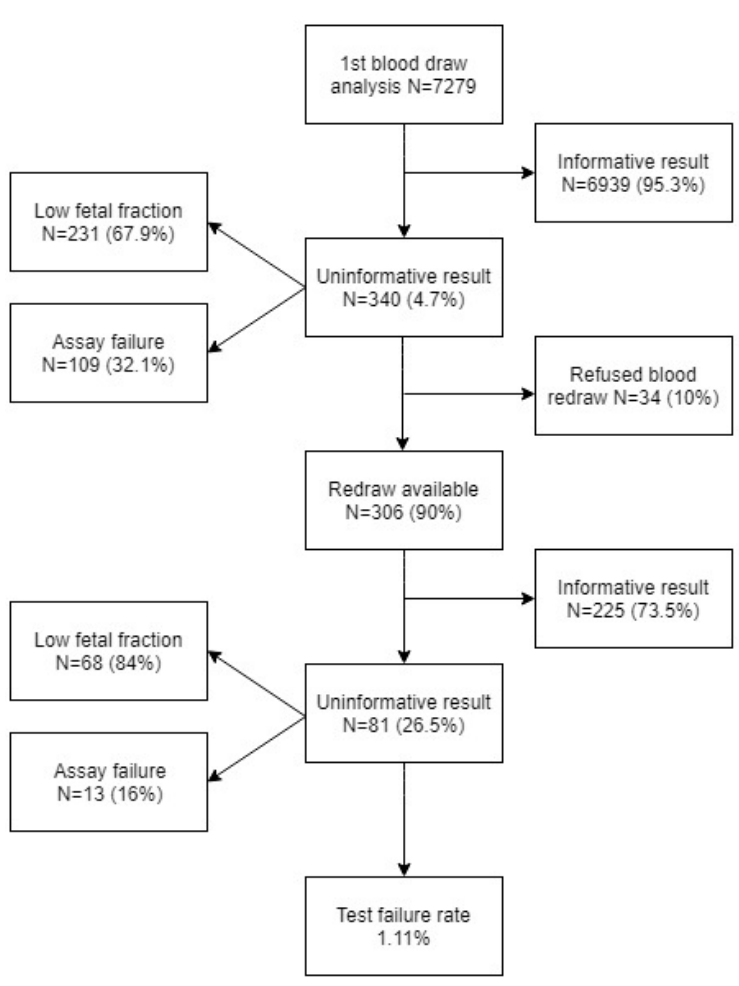
Figure 1. Structure of sample cohort regarding informative and uninformative results.